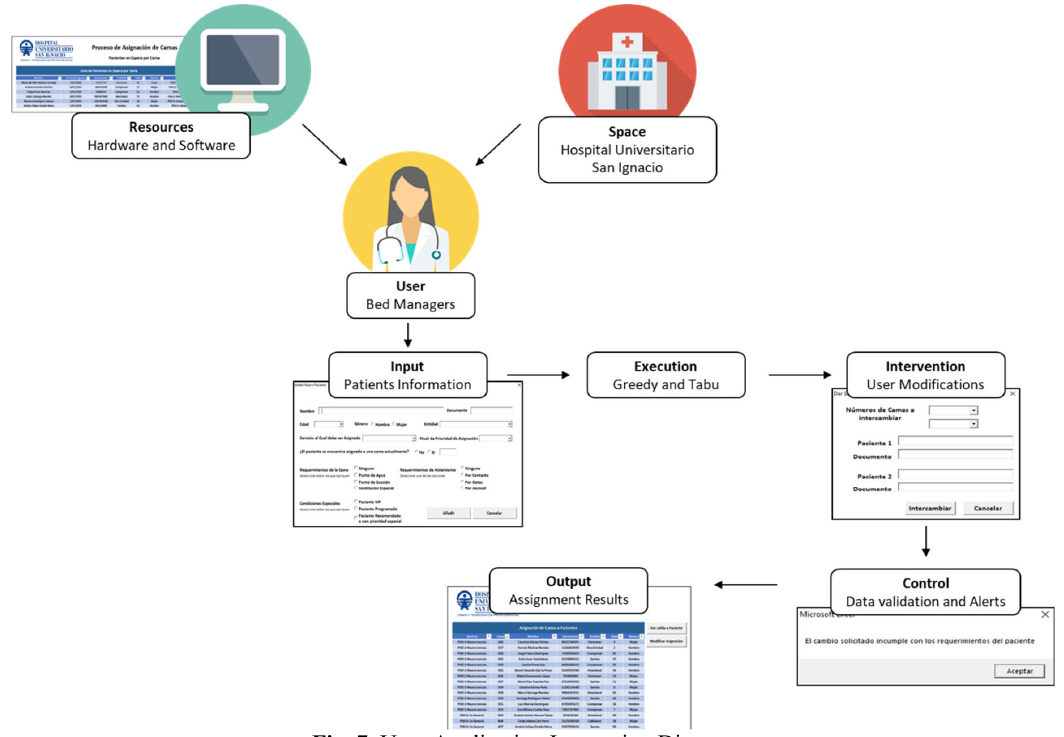
Fig. 7. User-Application Interaction